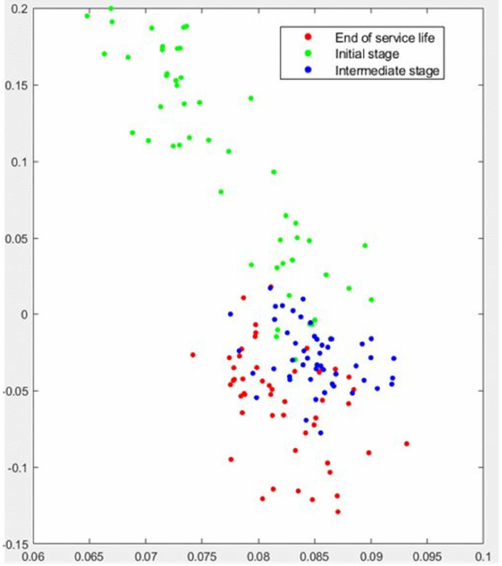
Figure 10. Graphical results of PCA analysis for Test No. 2.